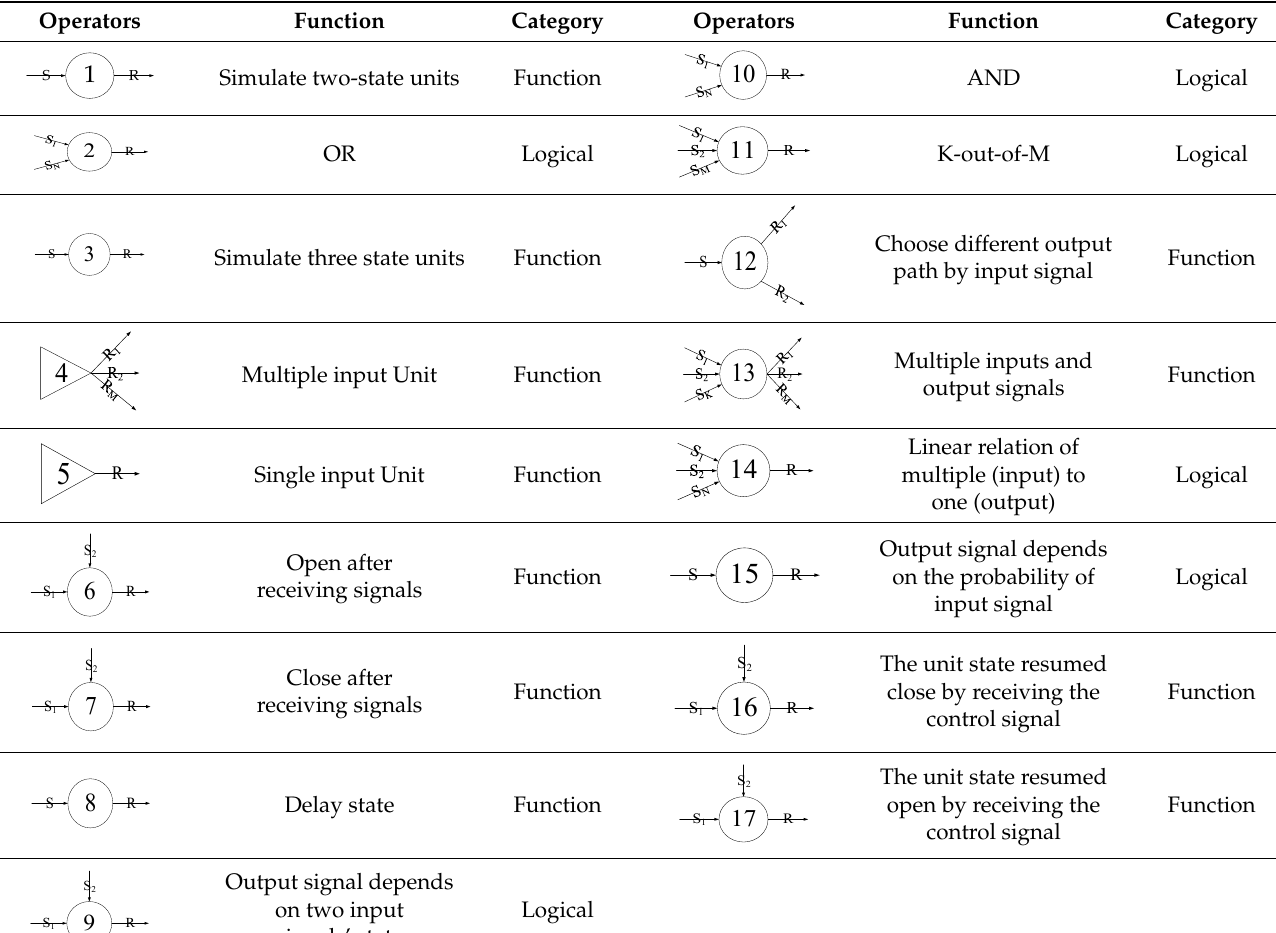
Table 1. Standard operators in the GO method.